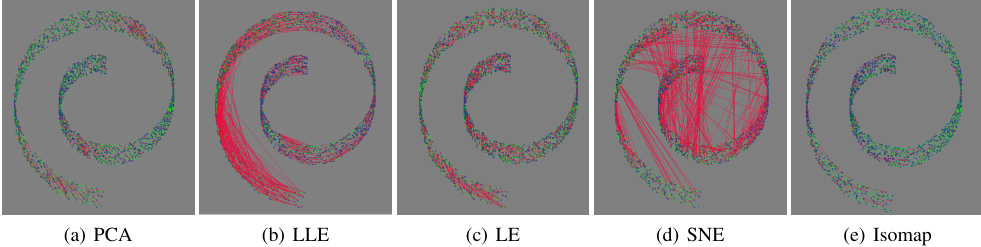
Figure 6: MST of neighborhood graph of Swiss-roll data points before and after dimension reduction. The green and red lines show the edges of trees before and after dimension reduction, respectively.